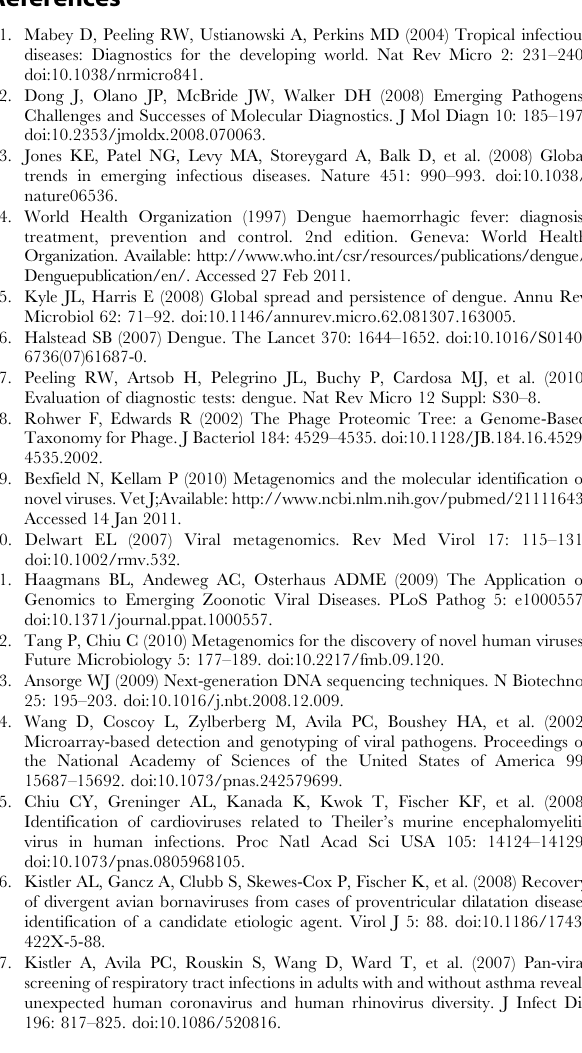
Figure S1 Virochip sensitivity using poliovirus control RNA. The Virochip can detect one poliovirus gRNA in a background of 10 5 HeLa RNA molecules. Poliovirus RNA was mixed with HeLa total RNA and analyzed on the Virochip. Eighty enterovirus Virochip oligos were found to be responsive to the poliovirus RNA and the mean fold above background of the normalized intensity of these oligos is plotted. Background is defined as the normalized intensity for each oligo in the HeLa-only control sample. The top E-predict hit in the 10 2 5 to 10 2 2 samples was human enterovirus C.